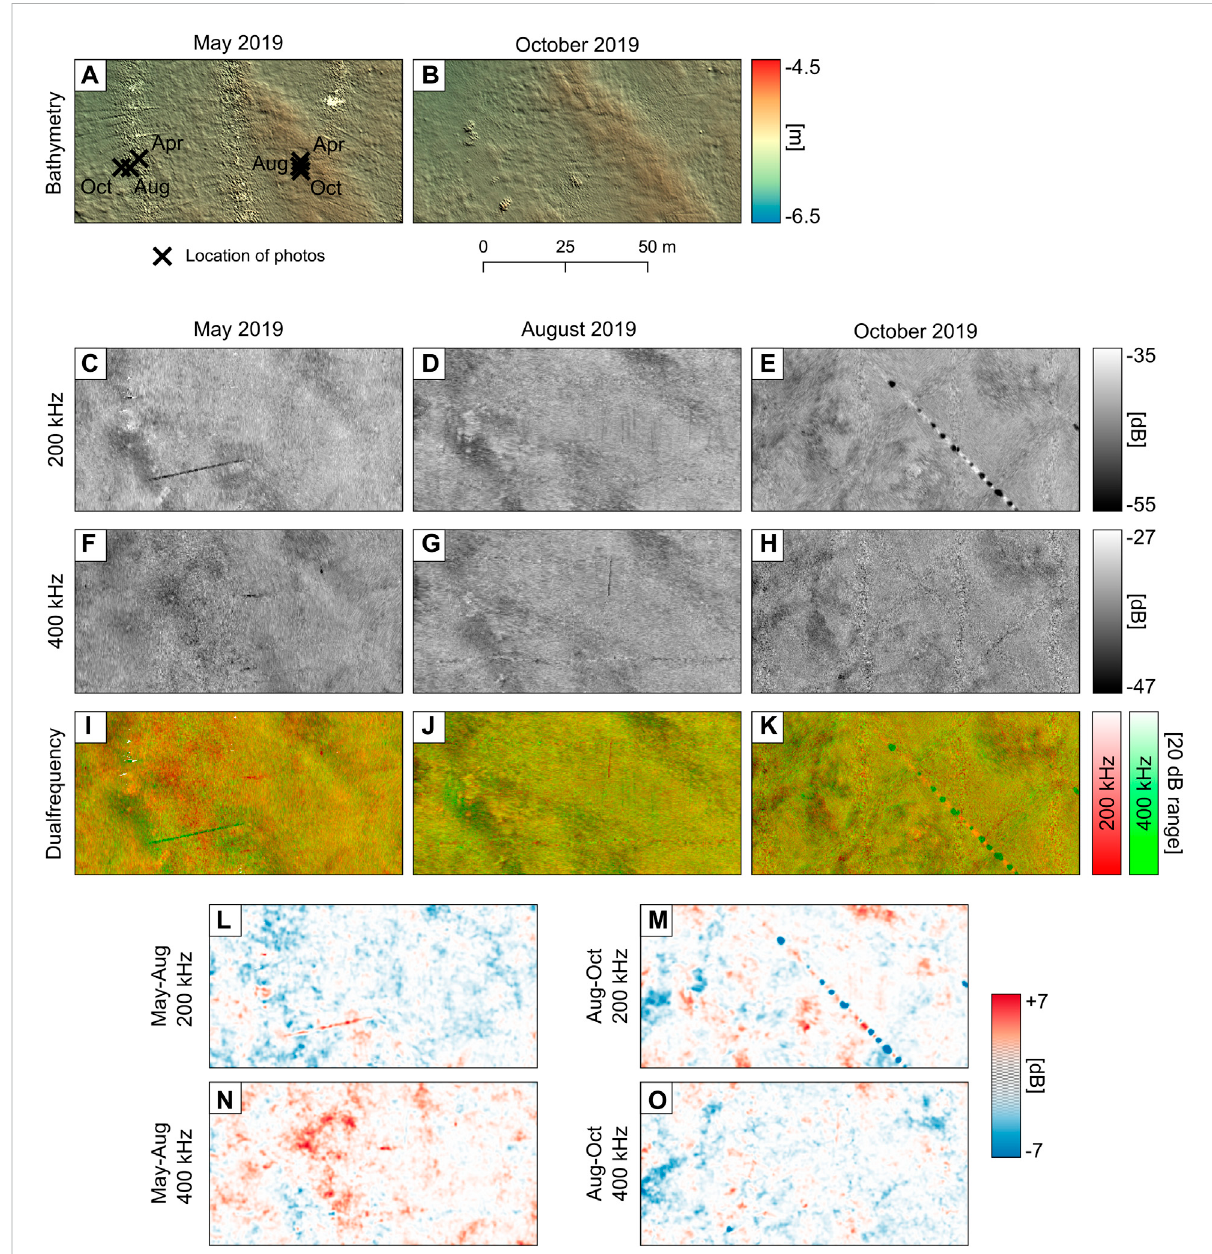
FIGURE 4 Detailedviewofacousticmapsofthereeffacies(forlocationseeFigure2B). (A,B) BathymetryinMay(200and400 kHzcombined)andOctober (400 kHz). The resolution is 0.25 m and a hillshade is added with sun azimuth of 35 ° and sun elevation of 20 ° . (C – E) Backscatter mosaic at 200 kHz frequency for May, August, and October 2019. (F – H) Backscatter mosaic at 400 kHz frequency for May, August, and October 2019. (I – K) Dual- frequency backscatter mosaic for May, August, and October 2019. The 200 kHz frequency is assigned to the red color channel and 400 kHz assigned to the green color channel. (L – M) Difference plots of the 200 kHz backscatter mosaics with a 5 cell lowpass fi lter showing the change betweenMaytoAugust(L)andAugusttoOctober(m). (N,O) Differenceplotsofthe400 kHzbackscattermosaicswitha5celllowpass fi ltershowing the change between May to August (N) and August to October (O)